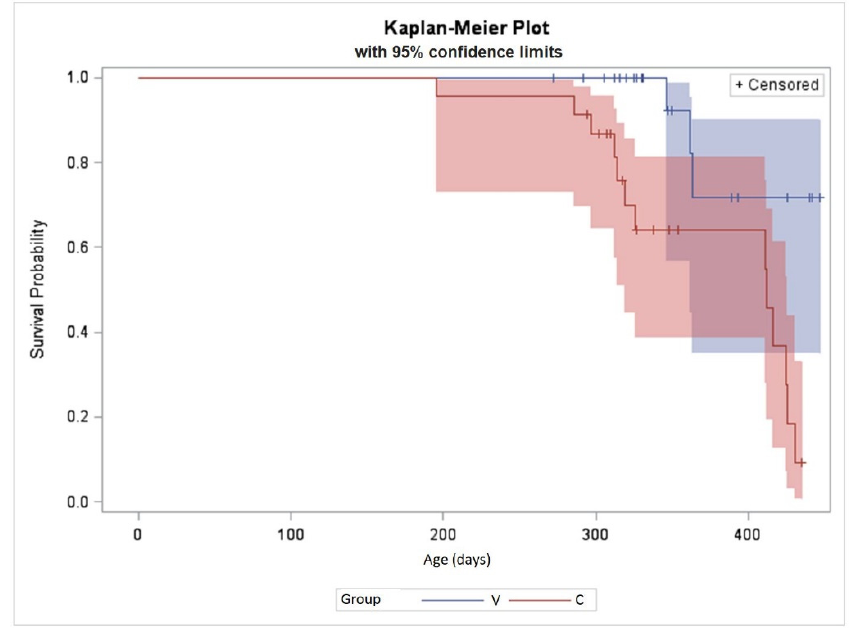
Figure 2. Kaplan–Meyer graph representing calves within groups V (blue) and C (red), versus the duration of the period between second vaccination and progesterone value > 1 ng/mL (Logrank test p = 0.0038) including the confidence limits of these data. + means censored data (calves slaughtered). Table 2. The McNemar test for the frequency table whether a vaccinated calf and a control calve within a farm had a progesterone value above 1 ng/mL during the whole measuring period revealed a significant difference ( p = 0.0047).